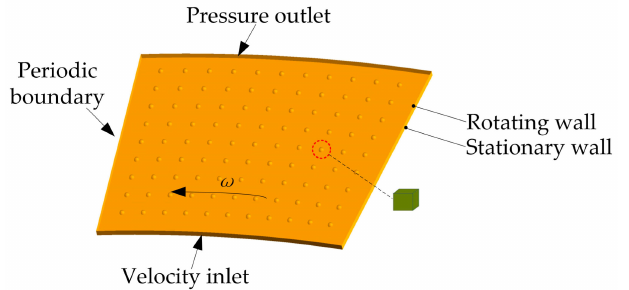
Figure 16. Boundary condition of flow field.